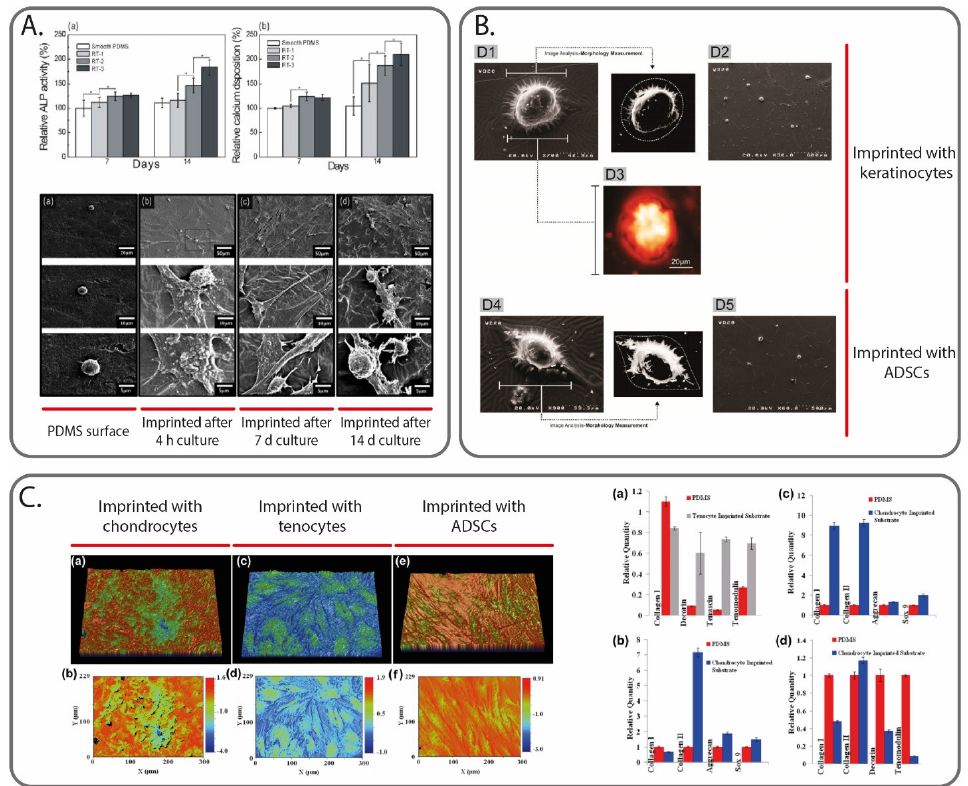
Figure 4. Cell MI to create physical cues able to guide cell activities. In ( A ), ALP activity and calcium deposition measured at 7 and 14 days for osteoblast-like cells culture on smooth PDMS surface, and on PDMS surface imprinted with the same cell type after different culturing times (4 h, 7 days and 14 days). Image reprinted with permission from [90]. In ( B ), atomic force microscope images of ADSCs cells cultured on a keratinocytes-imprinted and ADSCs-imprinted silicone substrate. Image reprinted with permission from [100]. In ( C ), profilometry images of the PDMS substrates imprinted with different cell types (chondrocytes, tenocytes and ADSCs), alongside the gene expression results of different cell cultures on the substrates (specifically, ( a , b ) ADSCs, ( c ) fibroblasts and ( d ) tenocytes). Image reprinted with permission from [101].